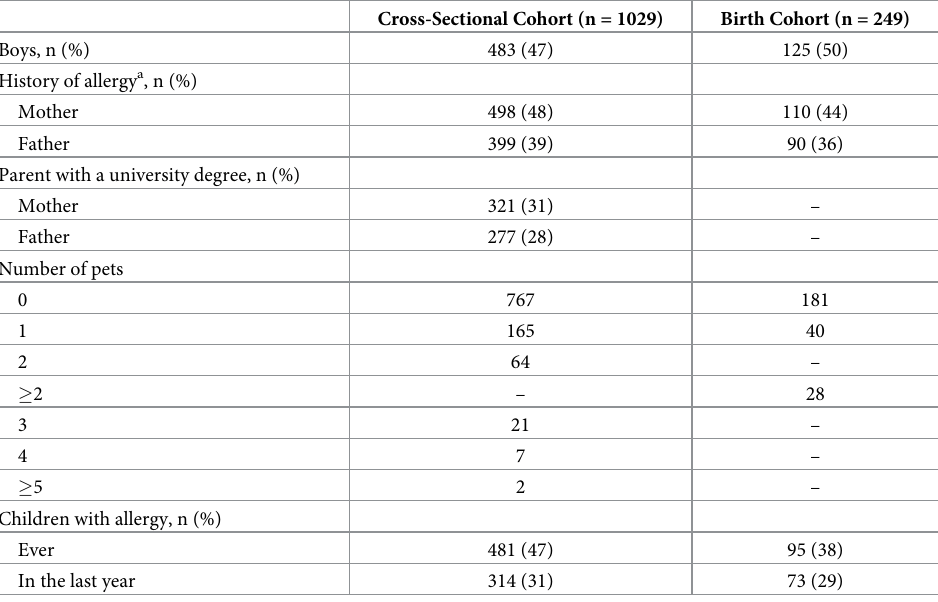
Table 2. Characteristics of the study